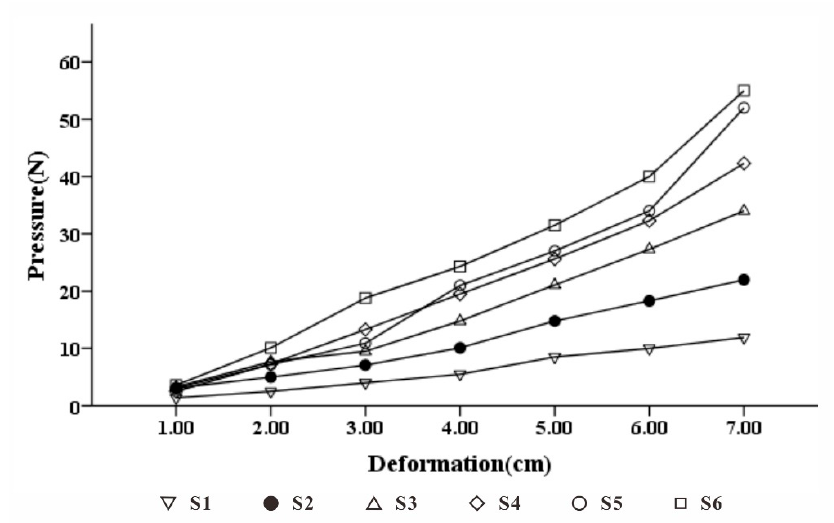
Figure 8. 60 D memory foam deformed under pressure with different apertures. Through the actual measurement, the aperture was used as the independent variable, Table 7. Measured equivalent elastic coefficient under different pore diameters (d). and the equivalent elastic coefficient k value was linearly regressed, as shown in Figure 9.